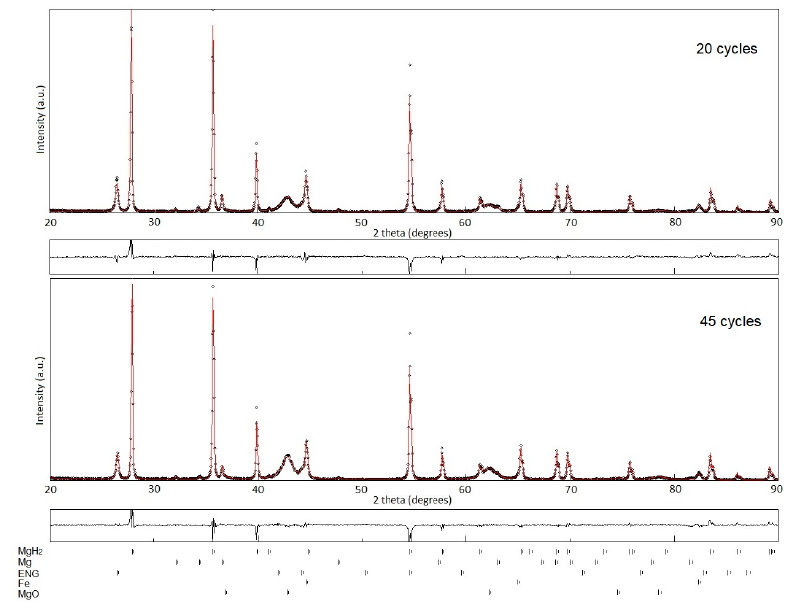
Figure 1. XRD patterns of MgH 2 –5Fe–5ENG pellets after 20 and 45 cycles. Experimental (black hollow dots), calculated (solid red line) and residues are shown.